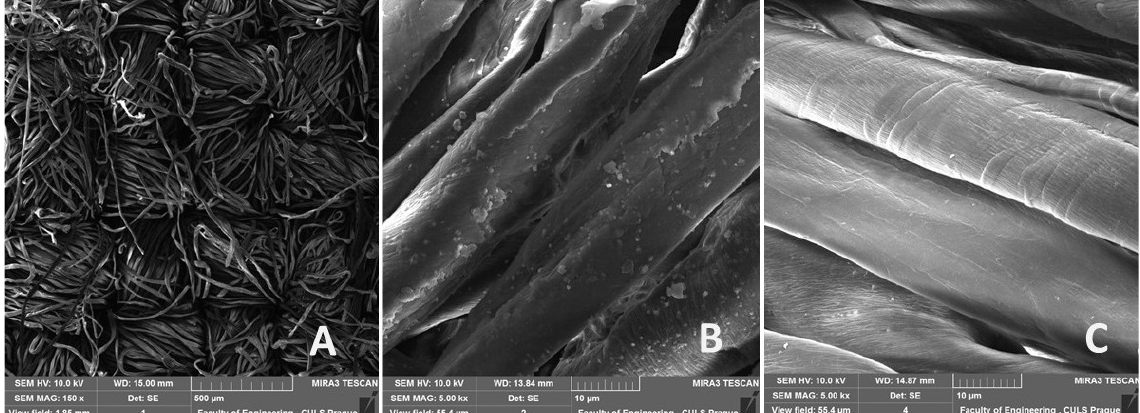
Figure 10. SEM images: ( A ): Cotton fabric Erik (MAG 150×); ( B ): Detailed look at the fabric—warp (cotton fiber) without alkali treatment (MAG 5000×); ( C ): Detailed look at the fabric—warp (cotton fiber) with alkali treatment in 10% NaOH solution for 30 min (MAG 5000×).